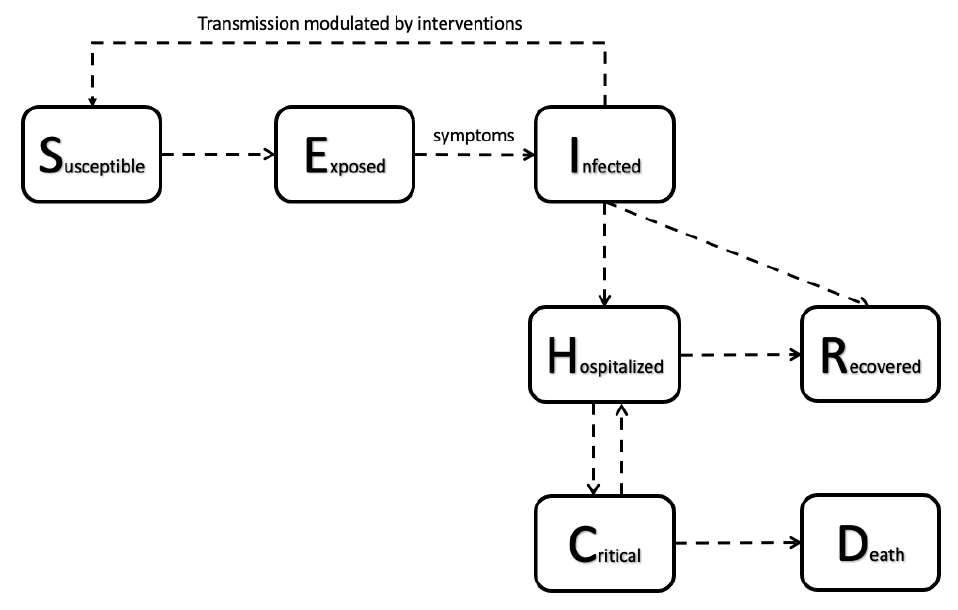
Figure 1. An illustration of the SEIR epidemiological model